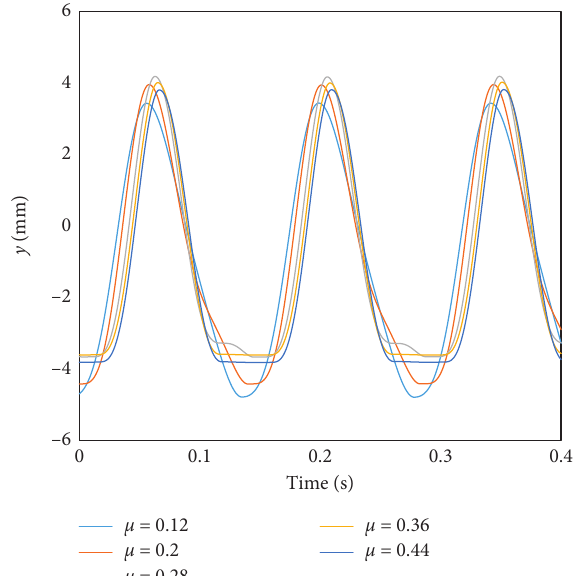
Figure 16: The influence of friction coefficient on the response of the suspension system when excitation amplitude � 15mm and frequency �